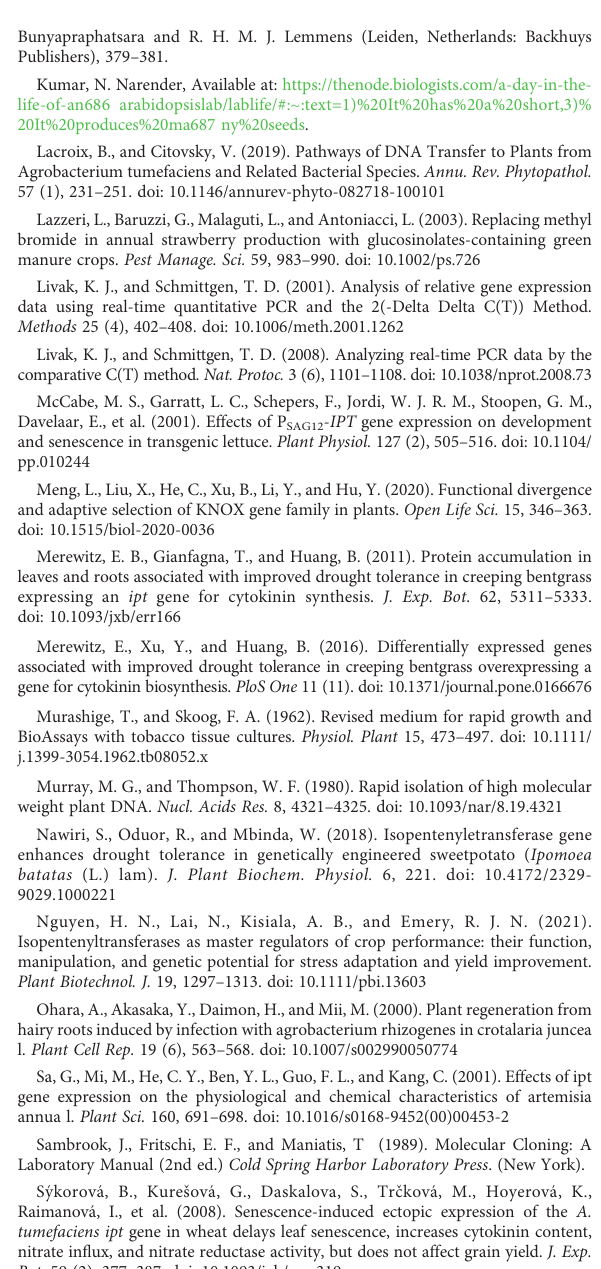
SUPPLEMENTARY FIGURE 1 Schematic diagrams of expression vectors under the control of CaMV 35S (A) and KNOX 1 (B) promoter. SUPPLEMENTARY FIGURE 2 Identi fi cation of representative of transgenic P . pellucida plant lines carrying integrated T-DNA resulted by PCR and Southern blotting analysis digested with Bam HI and Xho I. Molecular markers are indicated on the left. Lane M, molecular size marker 1 kb; Lane 1, transgenic control